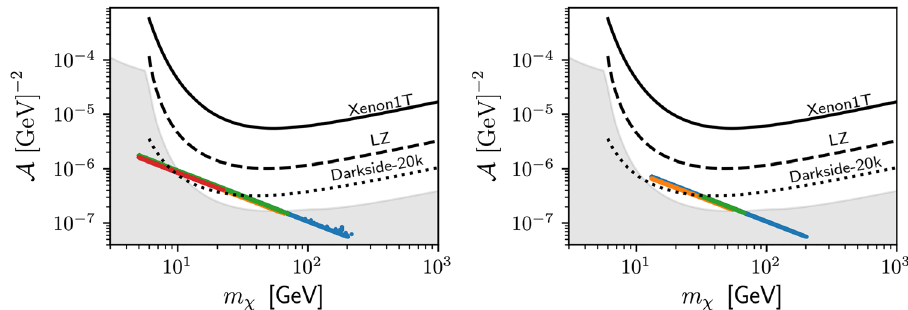
[94,95]andDarkSide-20k[96].Theshadedarearepresentstheneutrino floor. The plot on the right-hand side incorporates LHC constraints, explained in more detail in Sect.3